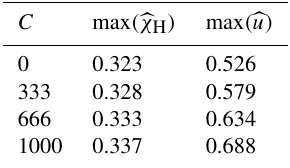
Table 4. Maximum Hayhurst stress and velocity for bed slipperiness coefficient